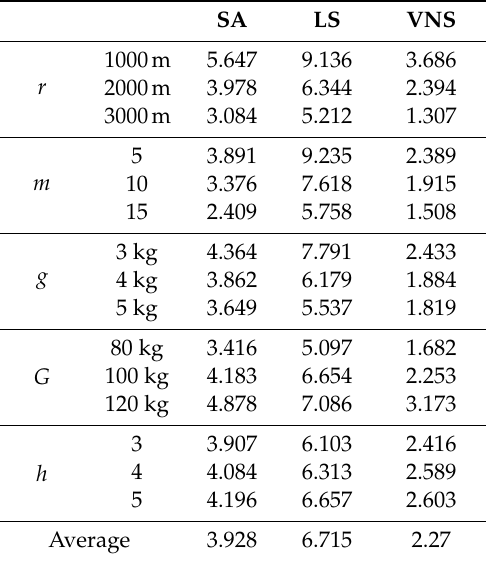
Table 2. ARPD values.